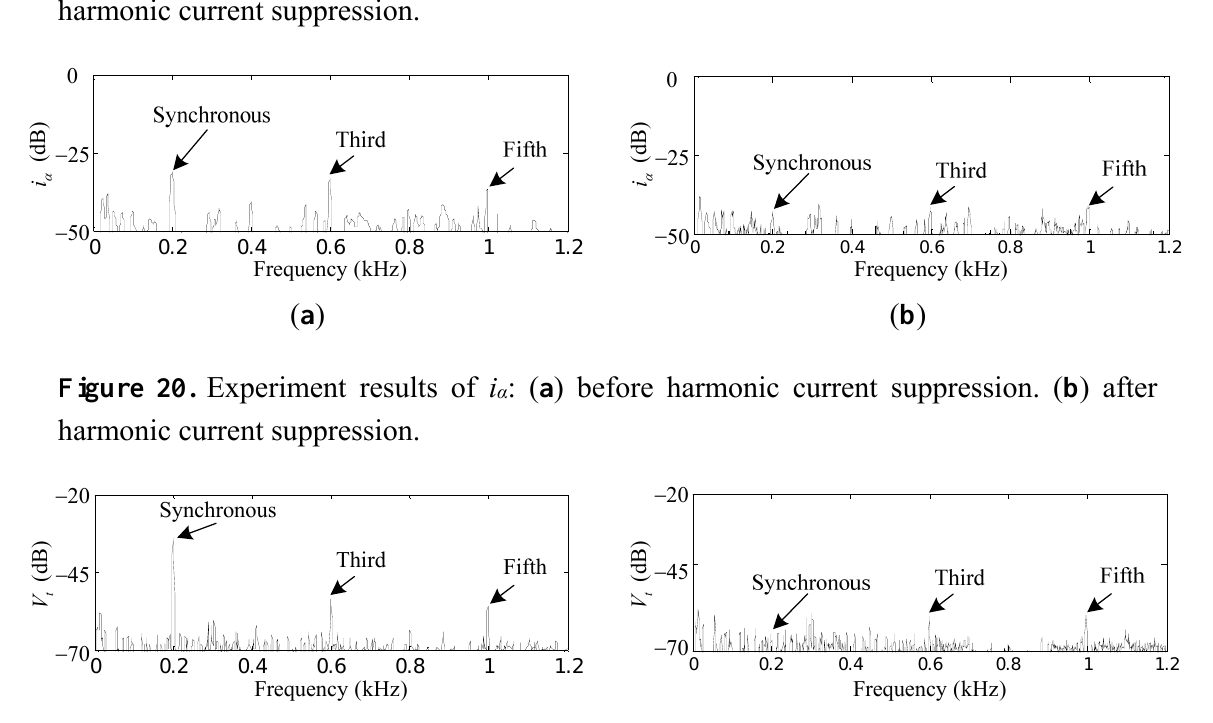
Figure 19. Experiment results of i x : ( a ) before harmonic current suppression; ( b ) after harmonic current suppression.